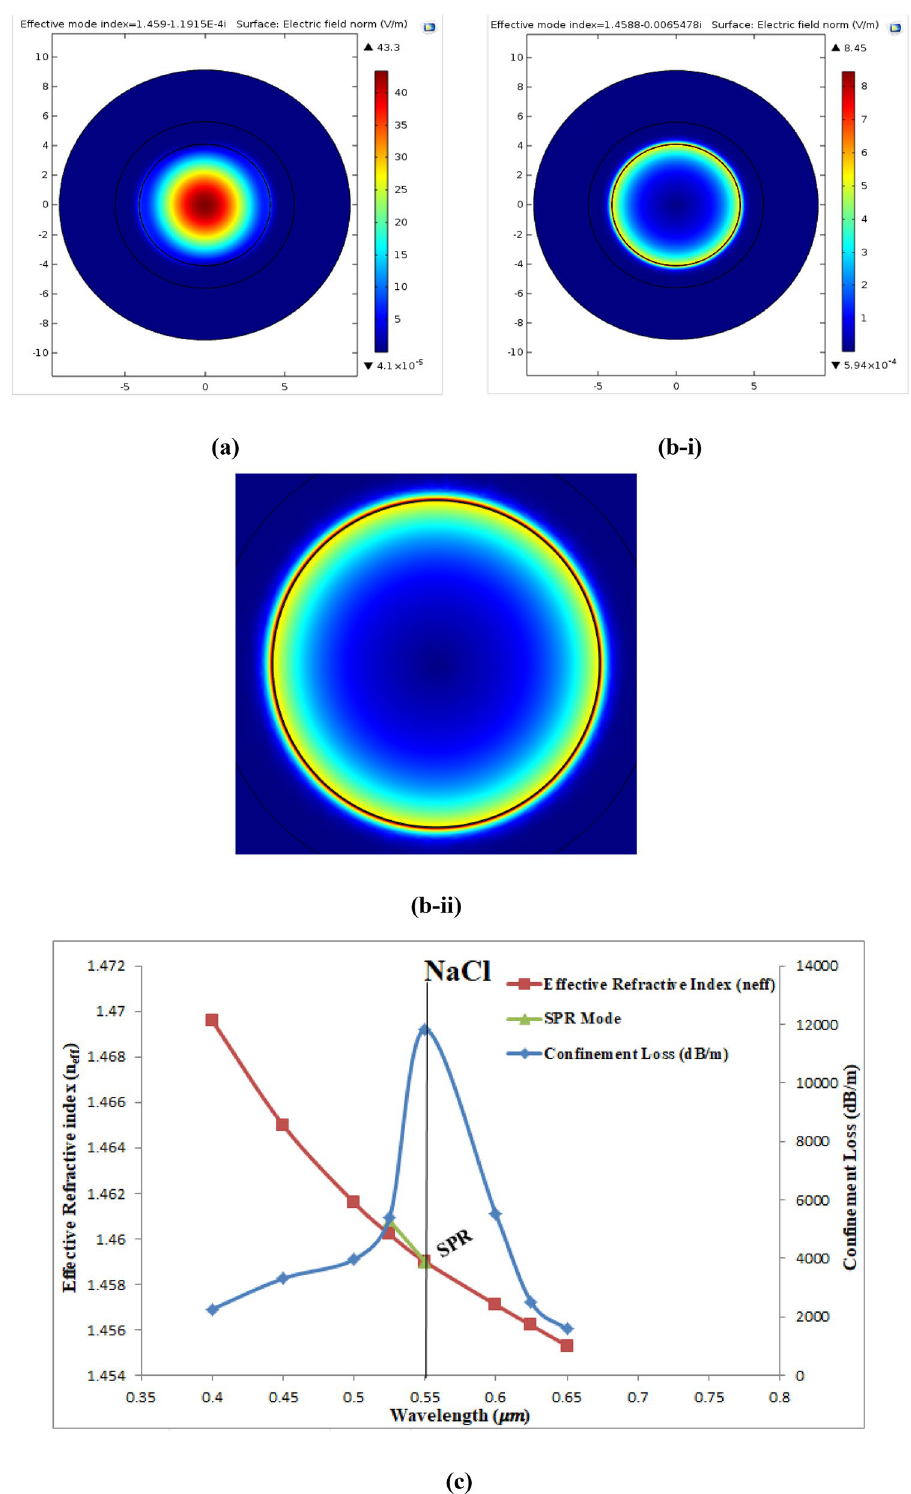
Figure 17. Presents ( a ) the fundamental mode of sucrose at 0.55 µm, ( b-i ) the SPR mode of NaCl-DI water at SPR wavelength of 0.55 µm, ( b-ii ) a magnified image for theSPR mode, and ( c ) Curves of the confinement loss (dB/m), Re(n eff ) of the fundamental mode and Re(n eff ) of SPR mode as a function of